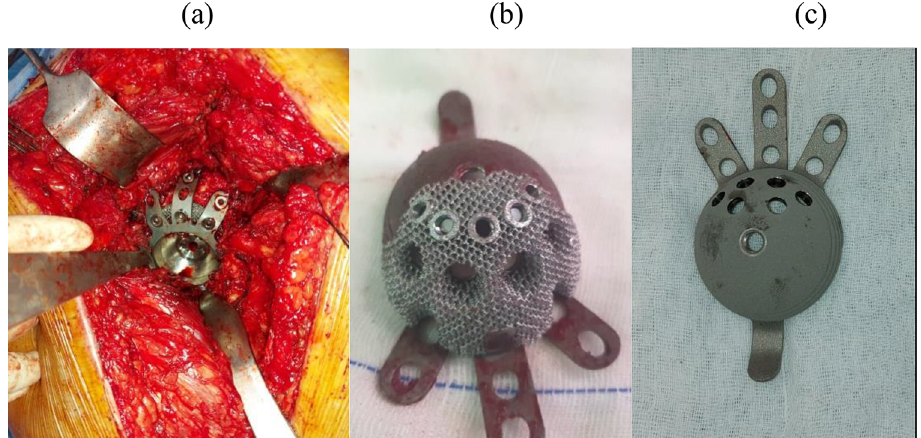
Figure 1. (a) Intraoperative image of the application of a TT revision cup with the addition of a hemispherical module. (b) Delta TT cup with augmenting fi xed with screws (c) cup before augmenting application.